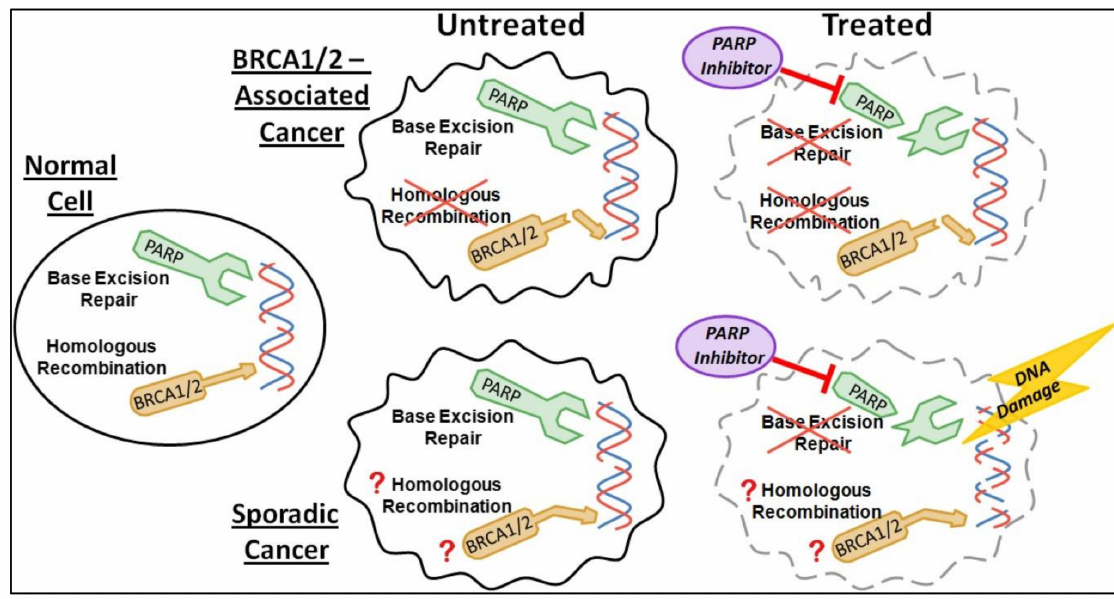
Figure 3. Poly (ADP-ribose) polymerase (PARP) inhibitor treatment of BRCA-1 / 2-associated and sporadic cancers. Reproduced with permission from Leif W. Ellisen. PARP Inhibitors in Cancer Therapy: Promise, Progress, and Puzzles. Cancer Cell. 2011, 19(2), 165–167